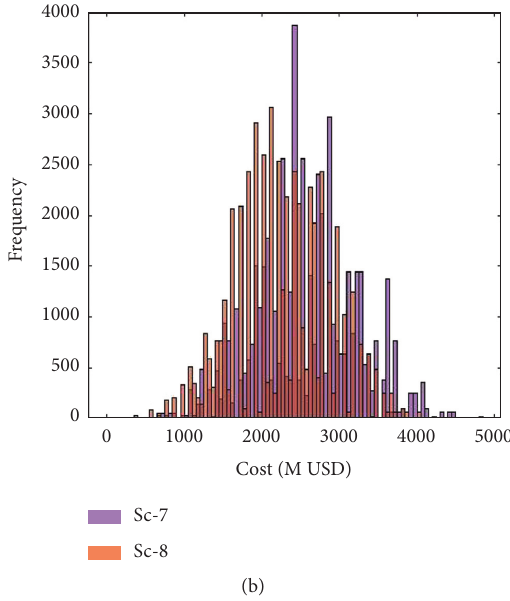
Figure 18: MATLAB simulations for case (a) and (b).